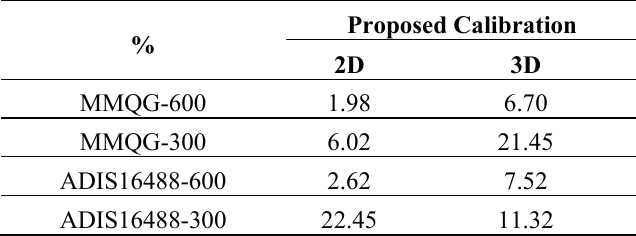
Table 5. The improvement rate of DG accuracy with the proposed method.